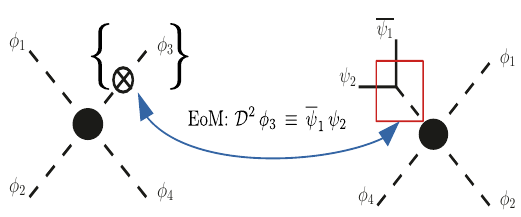
Figure 11 . Implementing the equation of motion of the scalar field to relate ( H † H ) ( H † D 2 H ) to operators of the ψ 2 φ 3